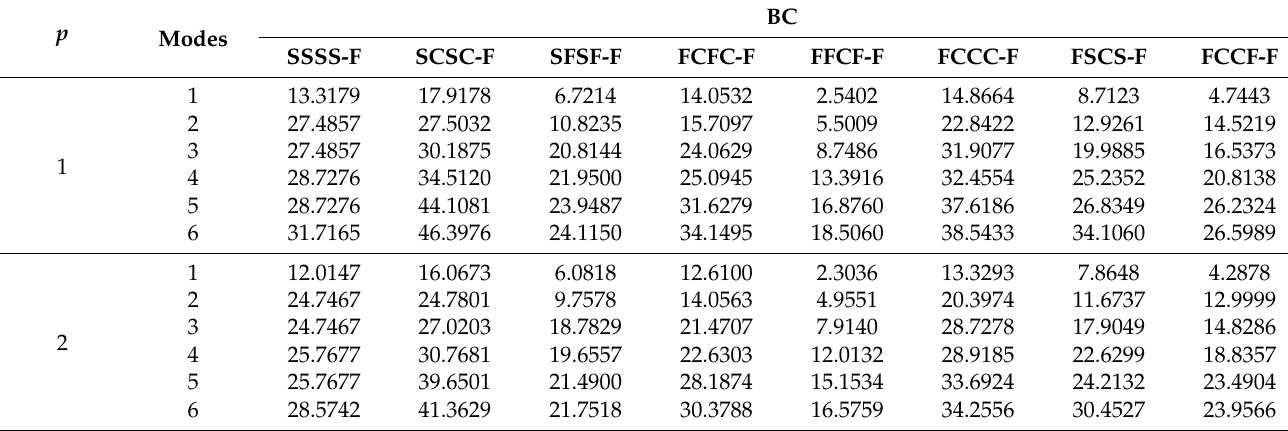
Table 5. The first six non-dimensional frequency parameters of the FGMs square plate with central circular cutout